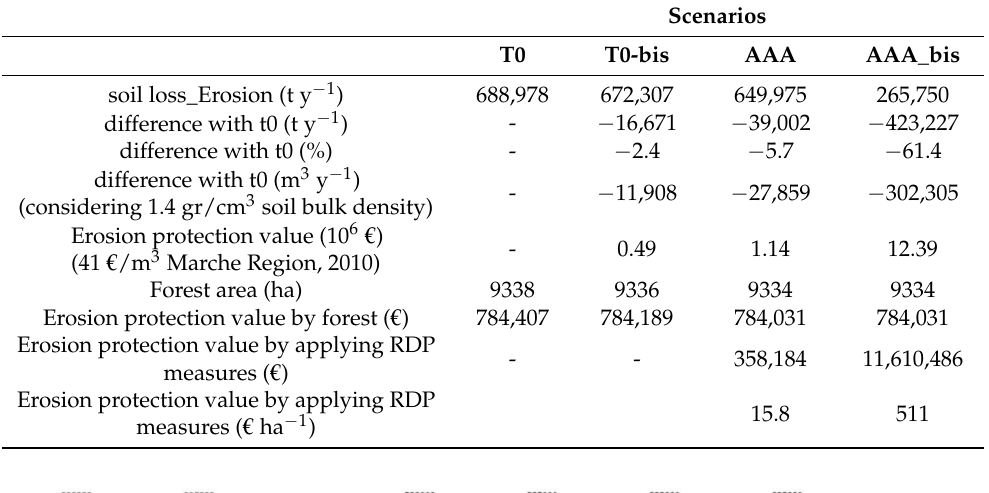
Table 6. Erosion protection value by erosion of each scenario.